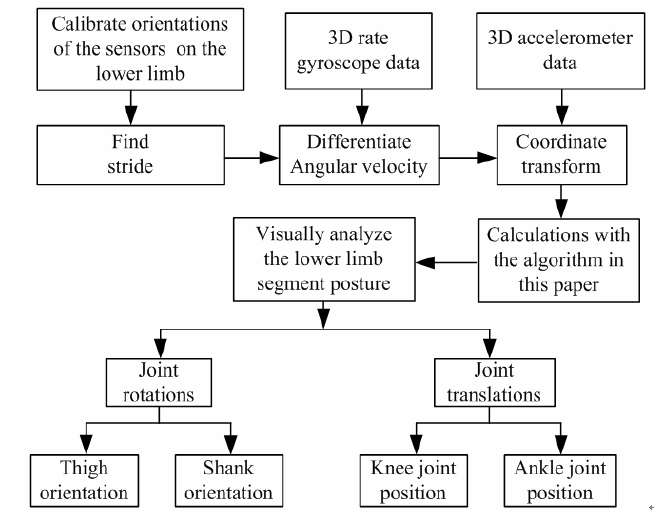
Fig.4 Schematic representation of the algorithm for deriving 3D thigh and shank orientations and the knee joint and ankle joint translations during gait on the basis of 3D inertial sensor signals.